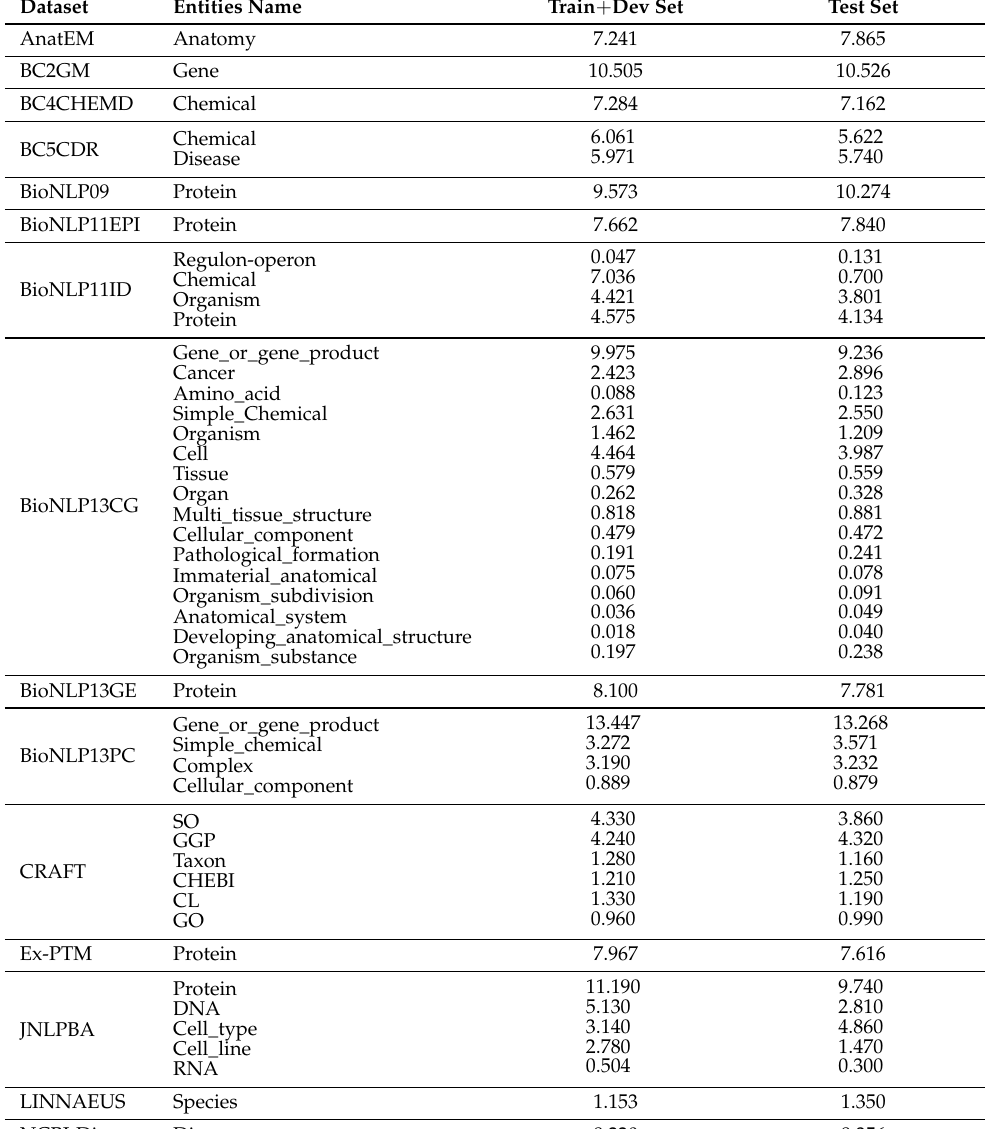
Table A2. Entities percentage distribution in training+development and test